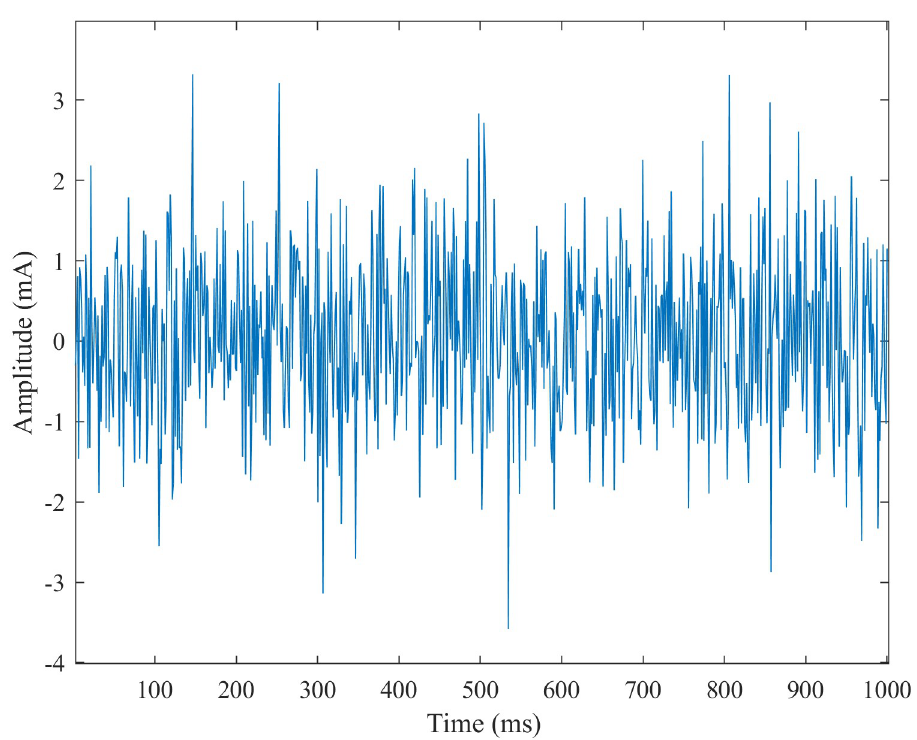
Fig 5. The white Gaussian noise current stimulation. change of the FRs with time under noise intensities of 0, 5, 10, 15, 20, 25 dBW are illustrated in Fig 6. From Fig 6, the FR gradually decreases and tends to be stable with time under different intensities of noise. The FR under noise intensities of 5, 10, 15, 20, 25 dBW have small change compared with that before noise stimulation (the noise intensity is 0 dBW), and the degree of the change of the FR gradually increases with the increase of noise intensity. Experiment results show that the SFSNN has a certain degree of noise suppression ability. To measure the degree of variation in the FR before and after noise stimulation, the change of the δ with time under noise intensities of 5, 10, 15, 20, 25 dBW are illustrated in Fig 7. From Fig 7: with the time, the all of δ rise sharply in the first 200 ms, rise slowly from 200 ms to 700 ms and tend to be stable after 700 ms under noise intensities of 5, 10, 15, 20, 25 dBW; when δ tend to be stable, the overall trend of the change of δ increase with the increase of noise intensity and δ are about 7%, 15%, 37%, 84% and 180% under noise intensities of 5, 10, 15, 20, 25 dBW, respectively. The experiment results show that SFSNN has a certain degree of noise suppression ability, and the noise suppression ability becomes weak gradually with the increase of noise intensity from the δ . Noise suppression ability by correlation coefficient between membrane potentials. To investigate the noise suppression ability of the SFSNN under white Gaussian noise from the angle of ρ , the change of membrane potentials before and after noise stimulation is studied. The change of the membrane potentials with time under noise intensities of 0, 5, 10, 15, 20, 25 dBW are illustrated in Fig 8. From Fig 8, the membrane potentials gradually decrease and tend to be stable with time under different intensities of noise. The membrane potentials under different intensities of